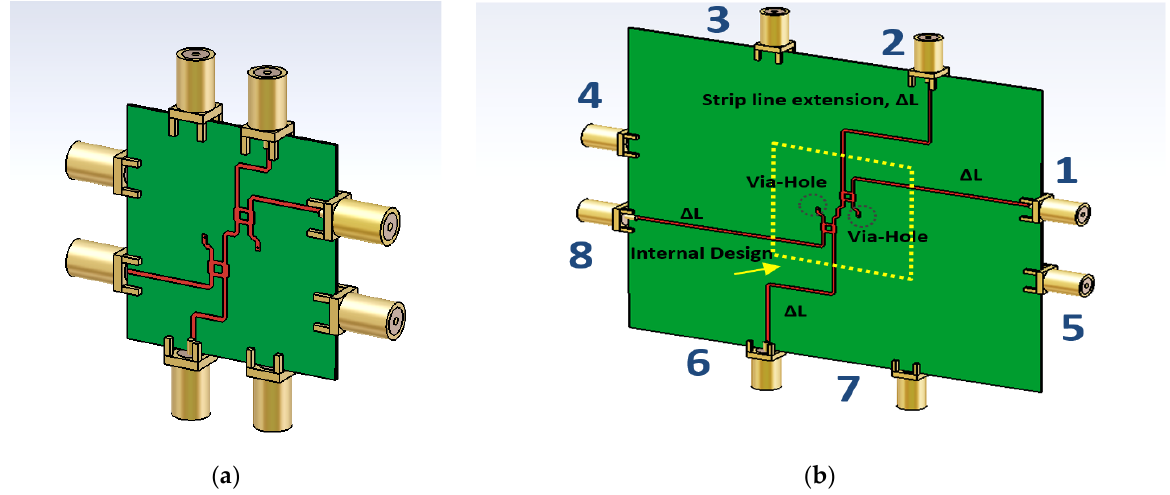
Figure 20. BM structure with ( a ) internal design ( b ) internal design with strip line extension, Δ L .